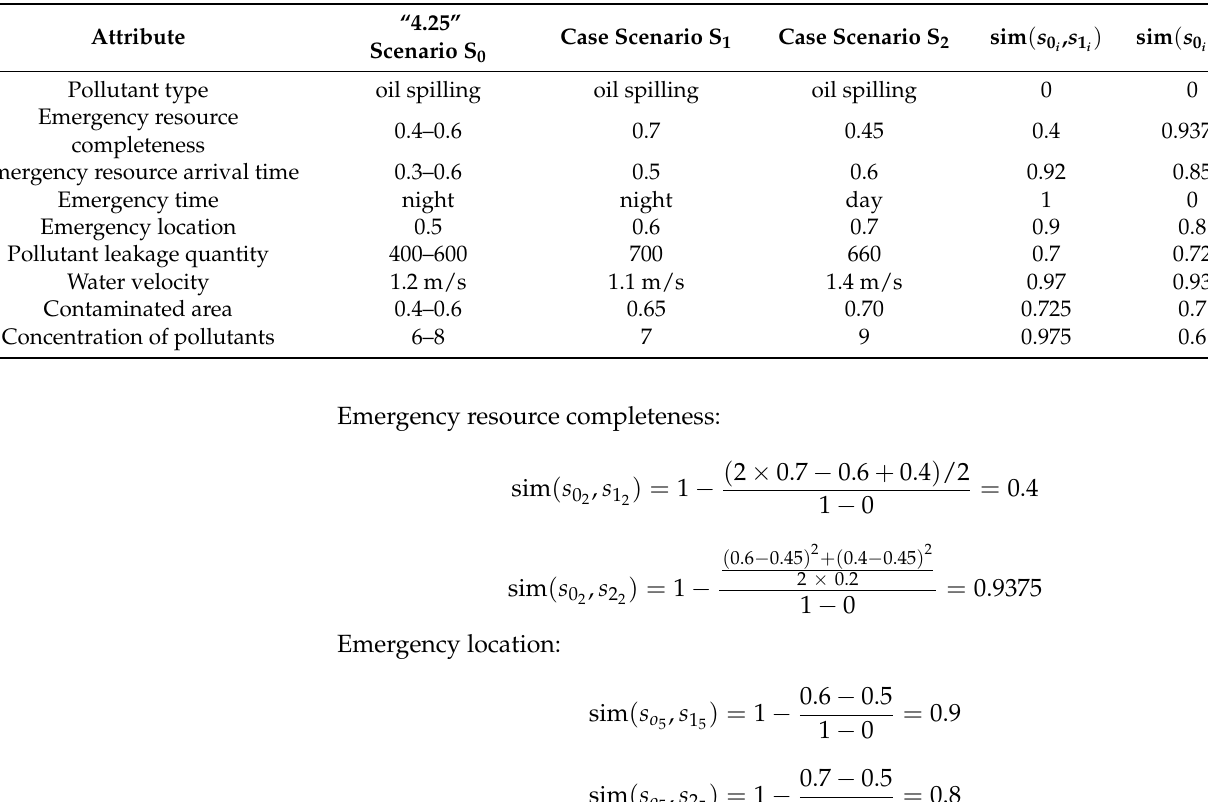
Table 9. Calculation results of similarity between “4.25 events” S 0 and case S 1 , S 2